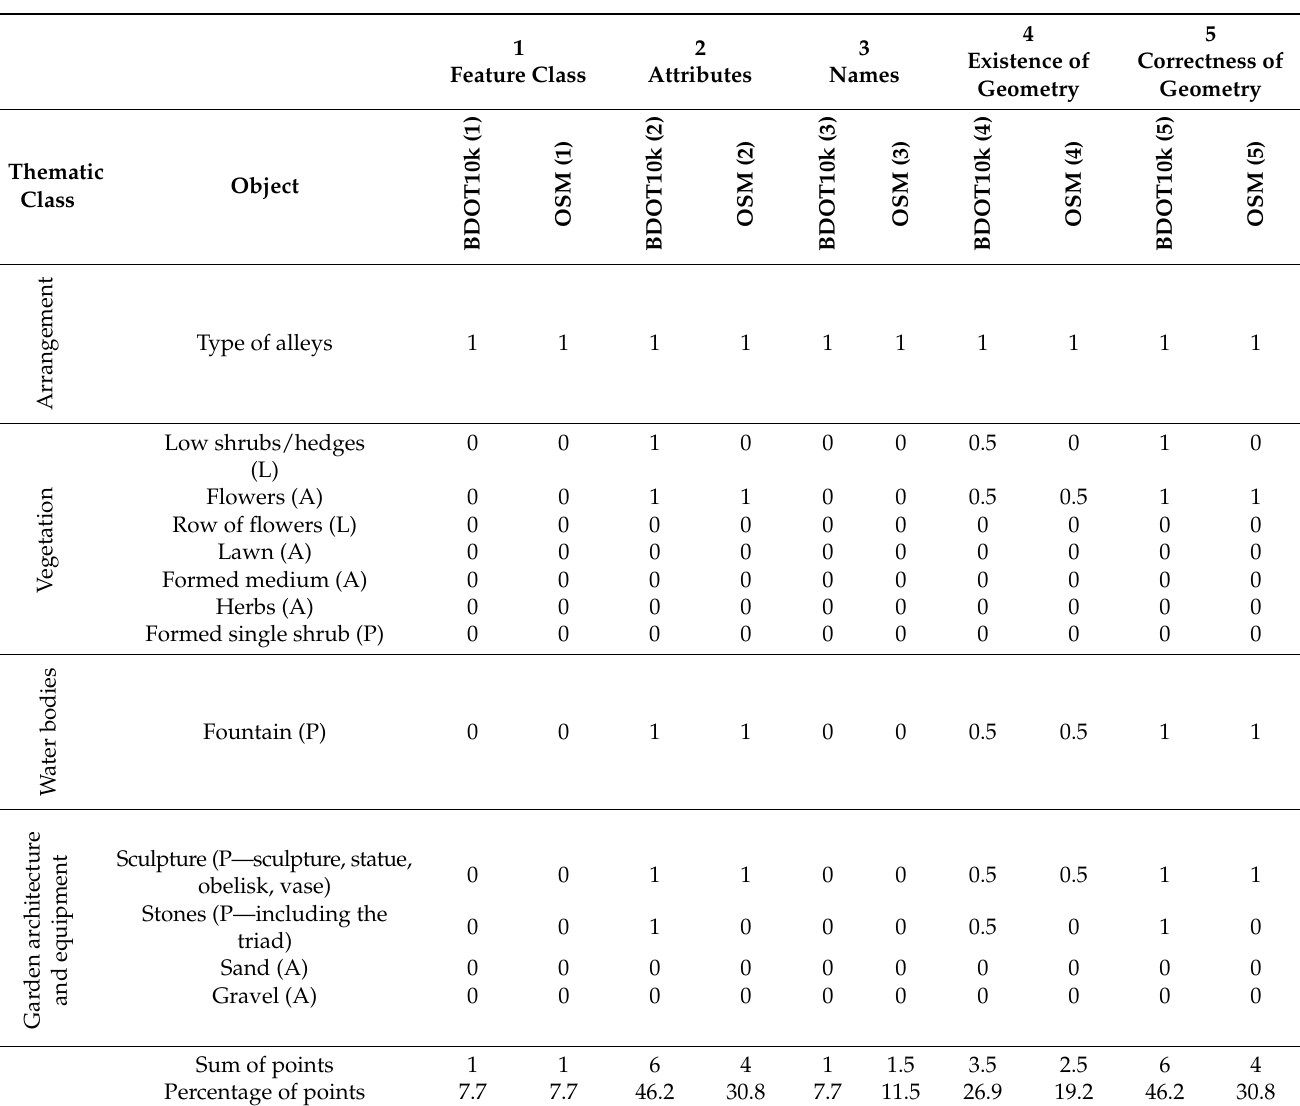
Table 3. OSM and BDOT10k assessment ratings—the third level of map detail. P, L, A—type of geometry (point, line,